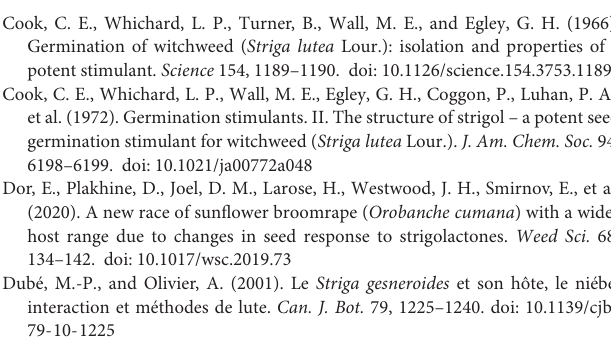
Supplementary Figure 1 | Orientation of O. cumana germ tubes in relation to gravity. Percentage of germ tubes growing away from the substrate if the Petri dish was either placed bottom-down ( n = 5 per substance) or bottom-up ( n = 2 per substance). In both cases, and with both STLs costunolide (10 − 4 M) and strigolactone GR24 (3.3 × 10 − 6 M), around 60% of the germ tubes grew away from the substrate and showed no gravitropism. Percentages are means ± standard deviation. No significant differences between the two treatments were found by the Tukey test ( p < 0.05). Supplementary Table 1 | Chemotropism data from root chambers and chemotropism